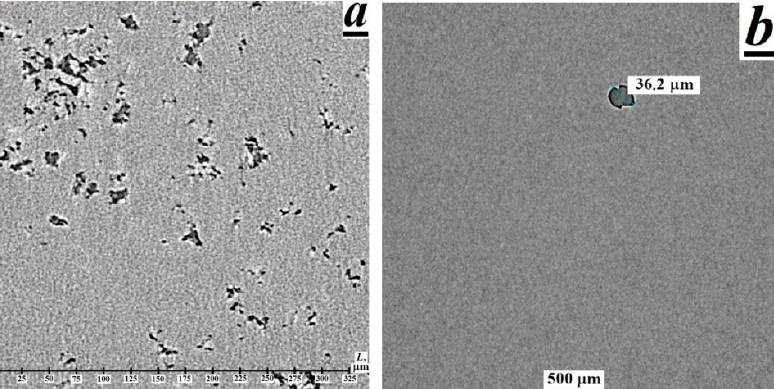
Figure 1. Three-dimensional image X-ray computed microtomography of a porous structure in the volume of a polytetrafluoroethylene sample ( a ) and the histogram of the size distribution of pores ( b ).